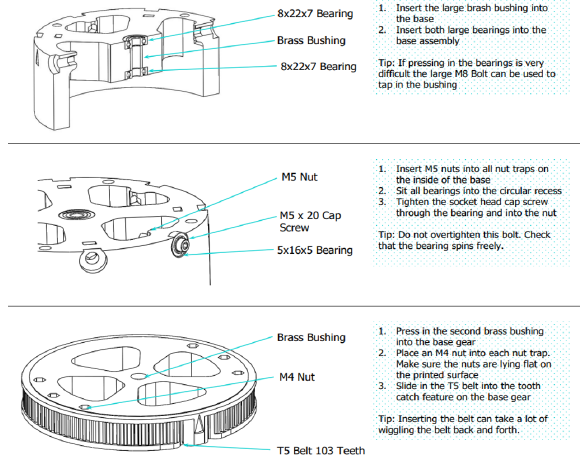
Fig. 2. Design for base assembly